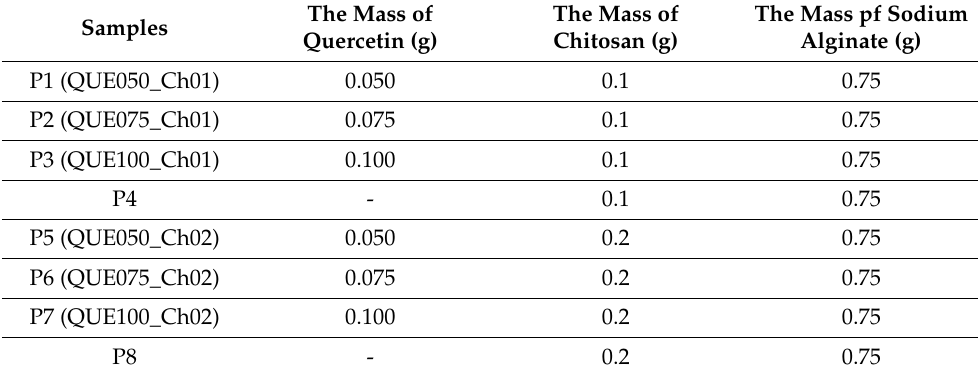
Table 1. Formulas of prepared quercetin